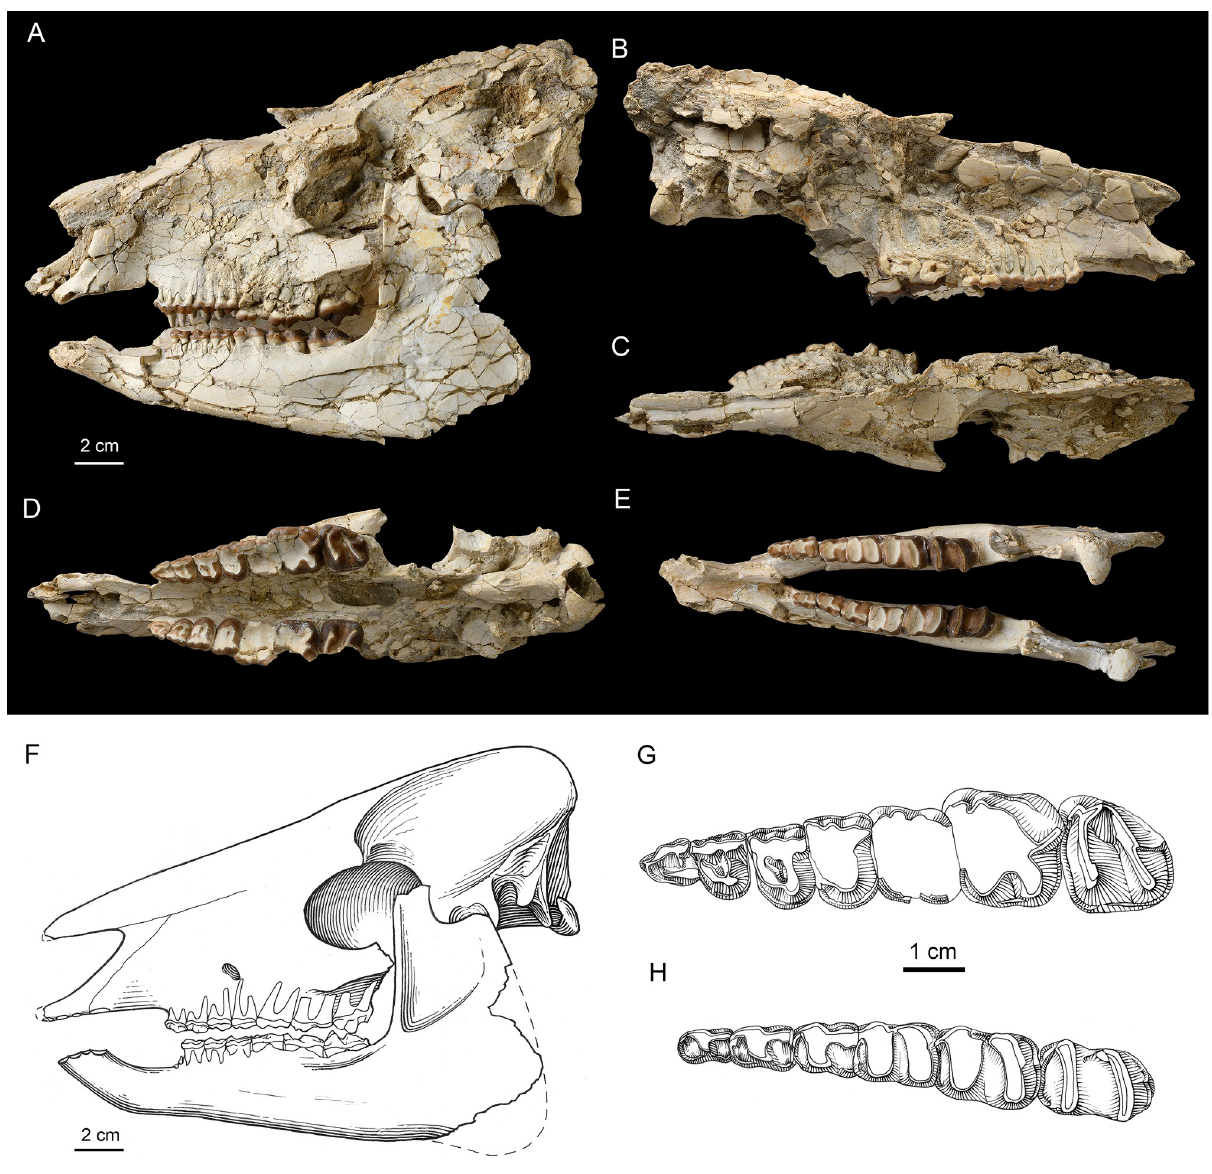
Fig 1. The skull and dentition of the primitive deperetellid tapiroid Irenolophus qii gen. et sp. nov. (IVPP V 25831) from the late early Eocene of the Erlian Basin, Inner Mongolia, China. (A) left lateral view of skull and mandible. (B) right lateral view of skull. (C) dorsal and (D) ventral views of the skull. (E) occlusal view of the mandible. (F-H) line drawing of the skull and mandible in lateral view (F), left P1-M3 in occlusal view (G), and right p2-m3 in occlusal view (H).